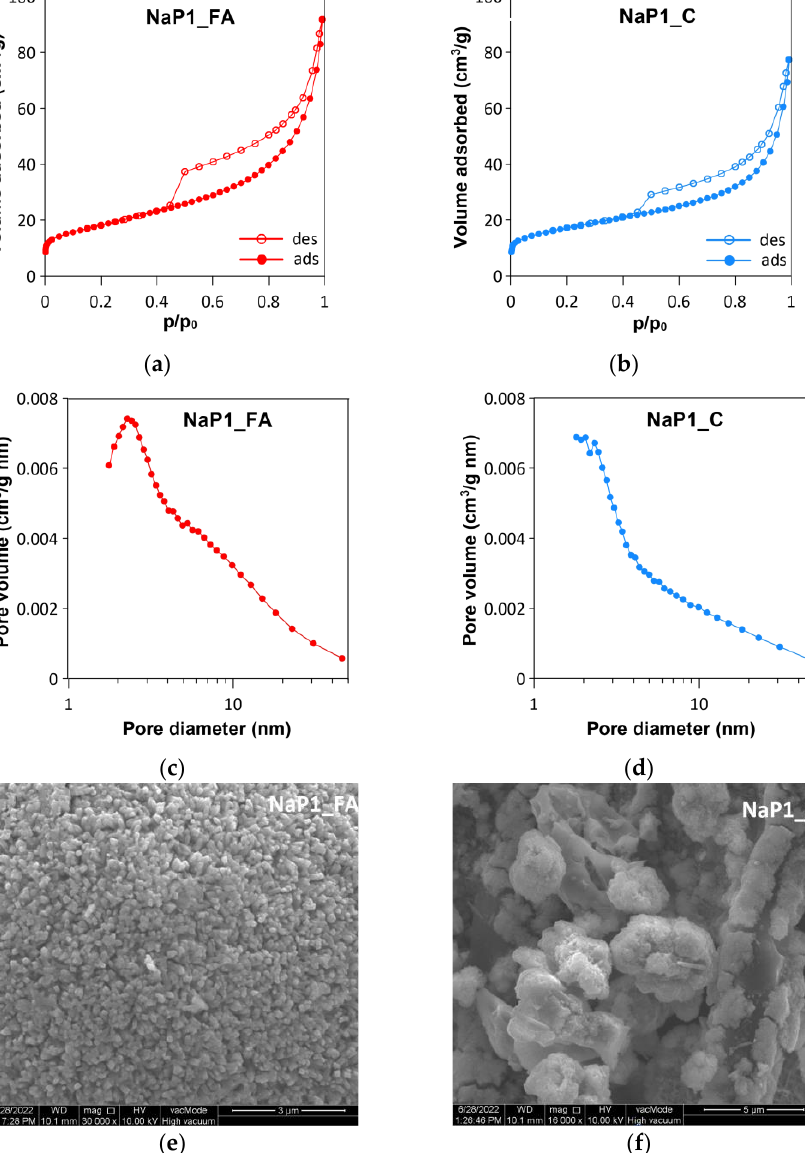
Figure 2. Thermal curves of ( 1 ) NaP1_C and ( 2 ) NaP1_FA [( a ) TG/DTA, ( b ) QMS].